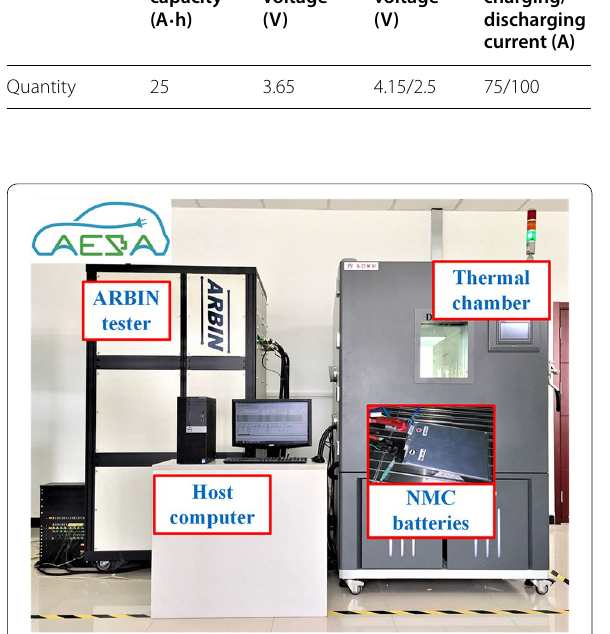
Table 1 Specifications of the NMC lithium ion batteries Specifications Nominal capacity